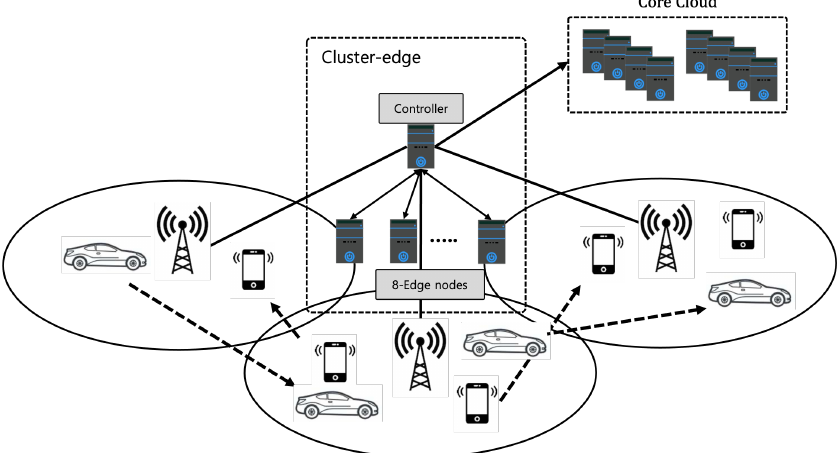
Figure 8. Network model of simulation scenario with mobile